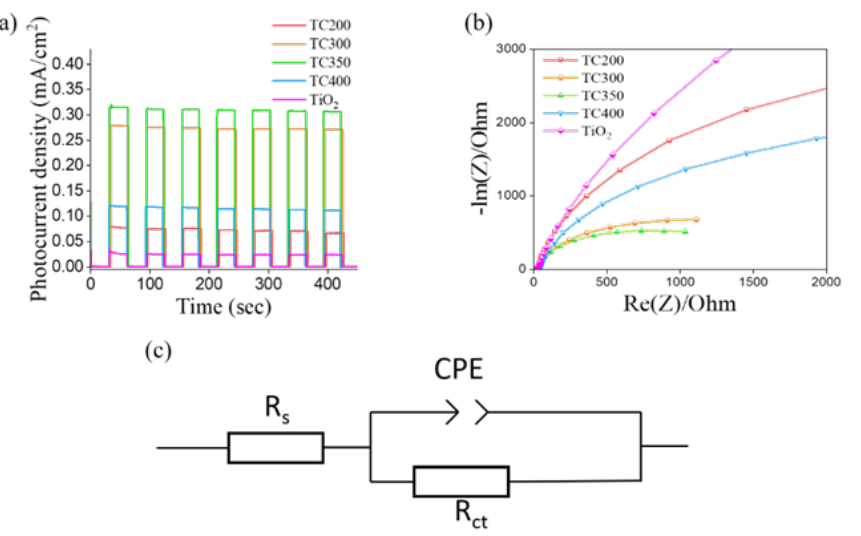
Figure 9. ( a ) Photocurrent density versus time curves for various samples at 1.2 V (vs. Ag/AgCl) under chopping illumination. ( b ) Nyquist plots for various samples under irradiation. ( c ) Possible equivalent circuits for Rct evaluation.